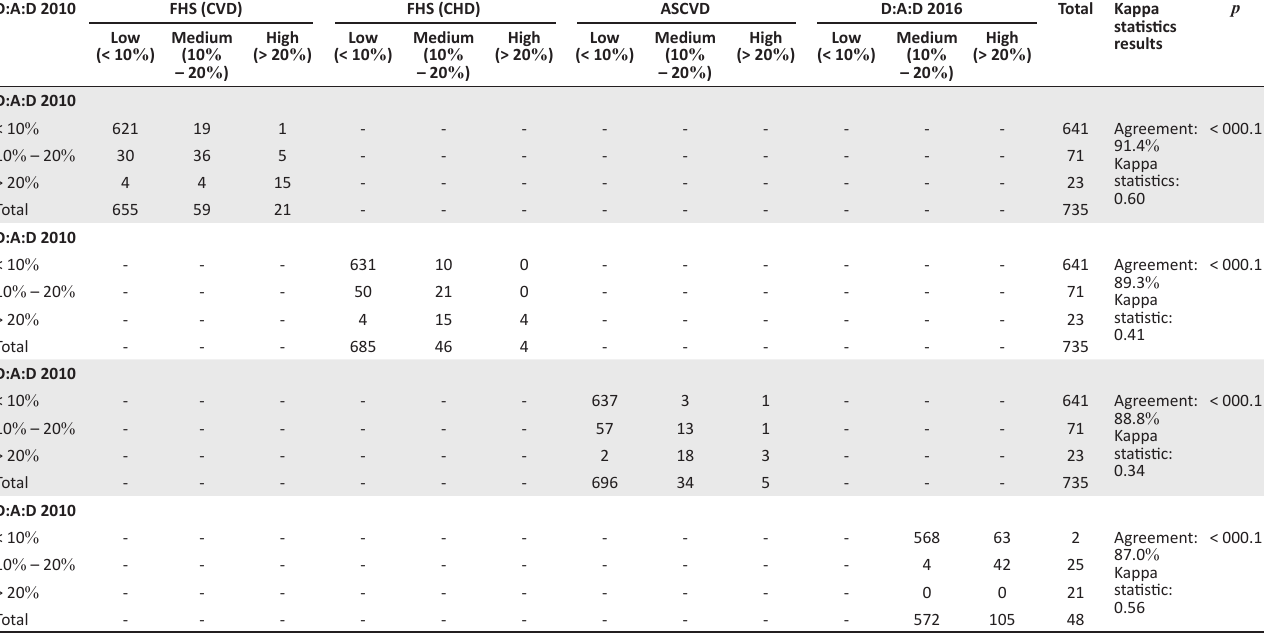
TABLE 3: Risk prediction: comparing the general cardiovascular disease models with the HIV-specific data collection on adverse events of anti-HIV drugs (D:A:D) 2010 model. D:A:D